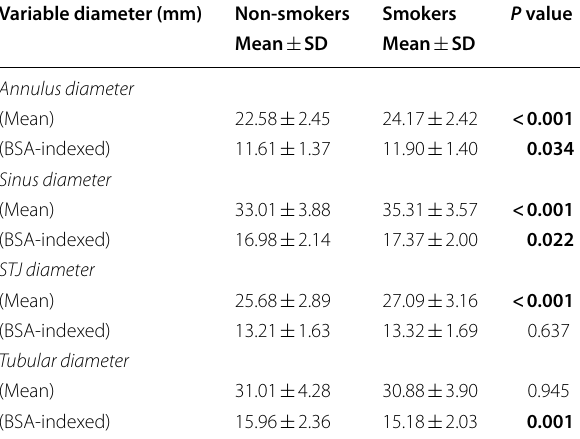
Table 23 Comparison of ascending thoracic aorta diameters in smokers and non‑smokers